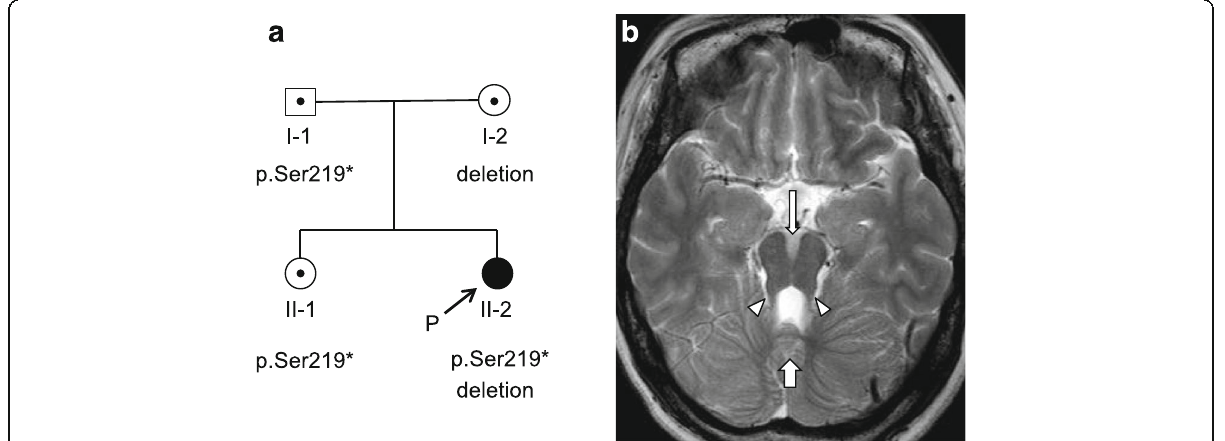
Fig. 1 a Pedigree of the family. Squares : males; circles : females. The filled circle represents the patient with Joubert syndrome and related disorders. b Axial T2-weighted magnetic resonance imaging of the brain showing mildly thickened and elongated superior cerebellar peduncles (arrowheads), a deepened interpeduncular fossa (thin arrow), and vermian hypoplasia (thick